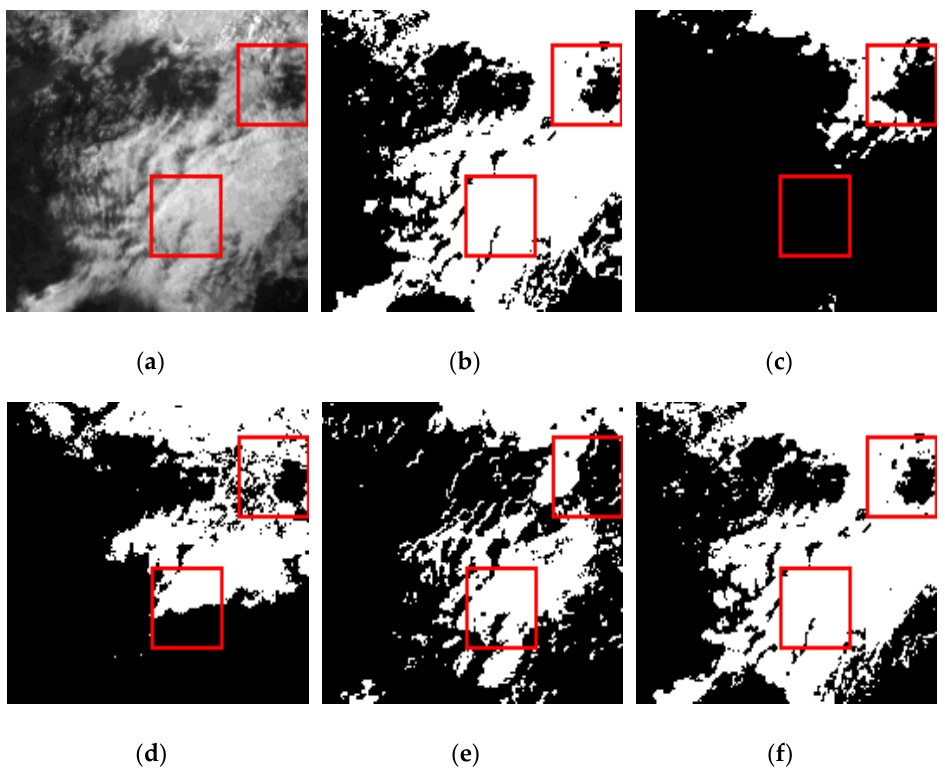
Figure 10. The enlarged subset of results. ( a ) Visible image; ( b ) Ground truth; ( c ) NSMC result; ( d )